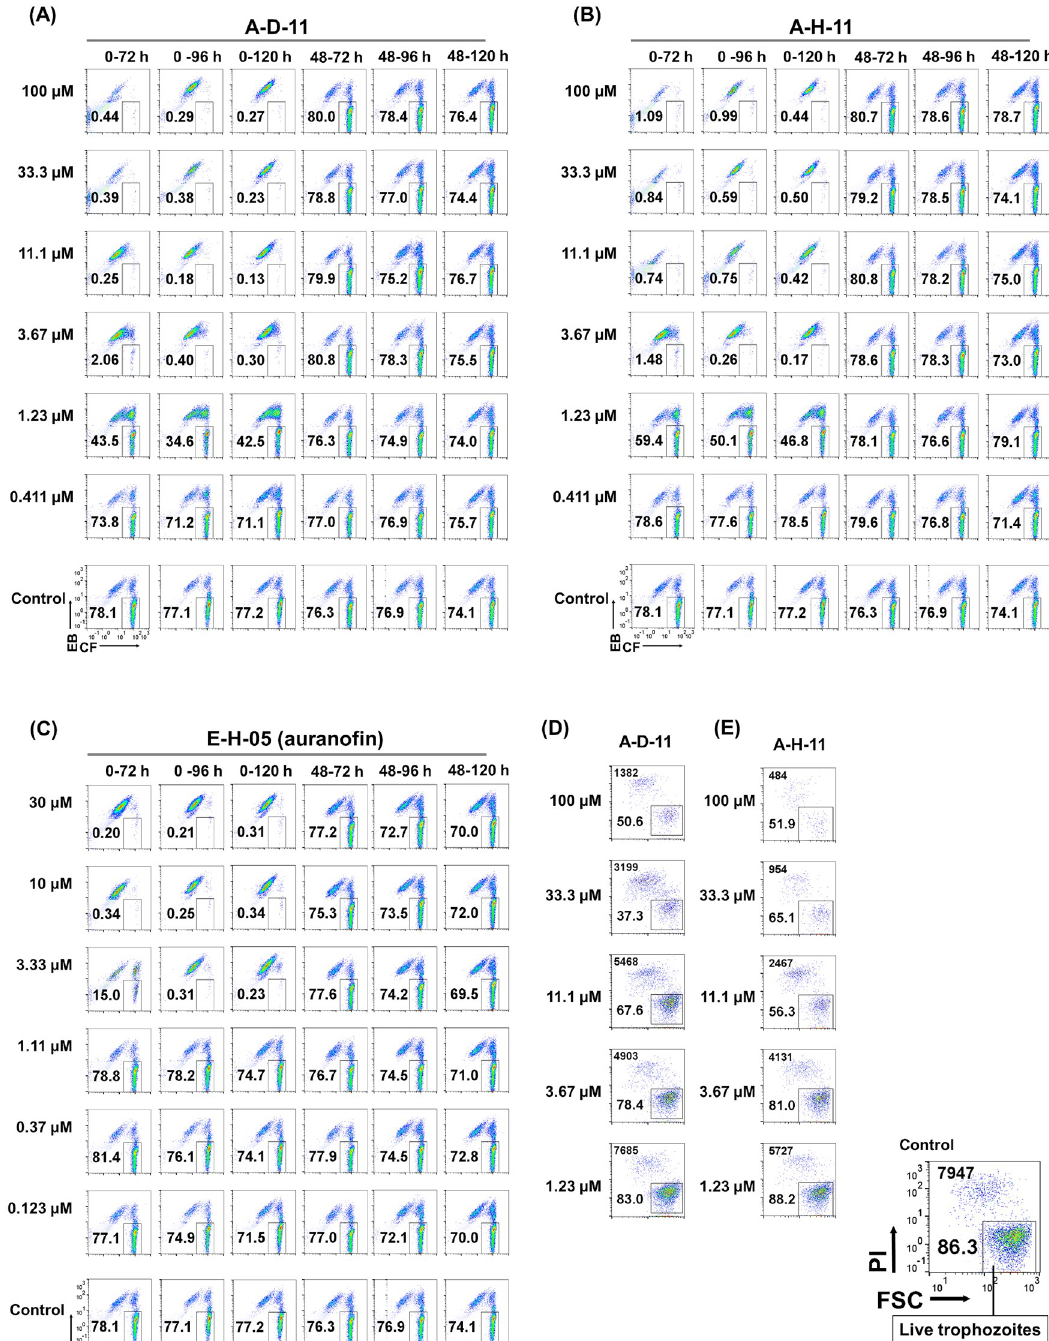
Fig 4. Effects of A-D-11, A-E-11, and E-H-05 (auranofin) on E . invadens cyst formation and of A-D-11 and A-E-11 on E . histolytica trophozoite proliferation. (A-C) Encystation assay. Encystation-inducing culture was treated with either A-D-11, A-E- 11, or E-H-05 (auranofin), immediately after induction (0 − 72, 0 − 96, or 0 − 120 h). Encystation-inducing culture was treated with either A-D-11, A-E-11 or E-H-05 (auranofin) from 48 h after induction (48–72, -96, or -120 h). Flow cytometry results obtained at 72, 96, or 120 h after induction are shown. EB, Evans blue; CF, calcofluor. (D, E) Trophozoite proliferation assay. The total cell number counted is indicated in the upper left corner. PI, propidium iodide; FSC, forward scatter. Representative data are shown from three independent experiments. Results for E-H-05 treatments (0 − 72 and 48 − 72 h), which we previously published [18], were confirmed in this study and are shown for ease of